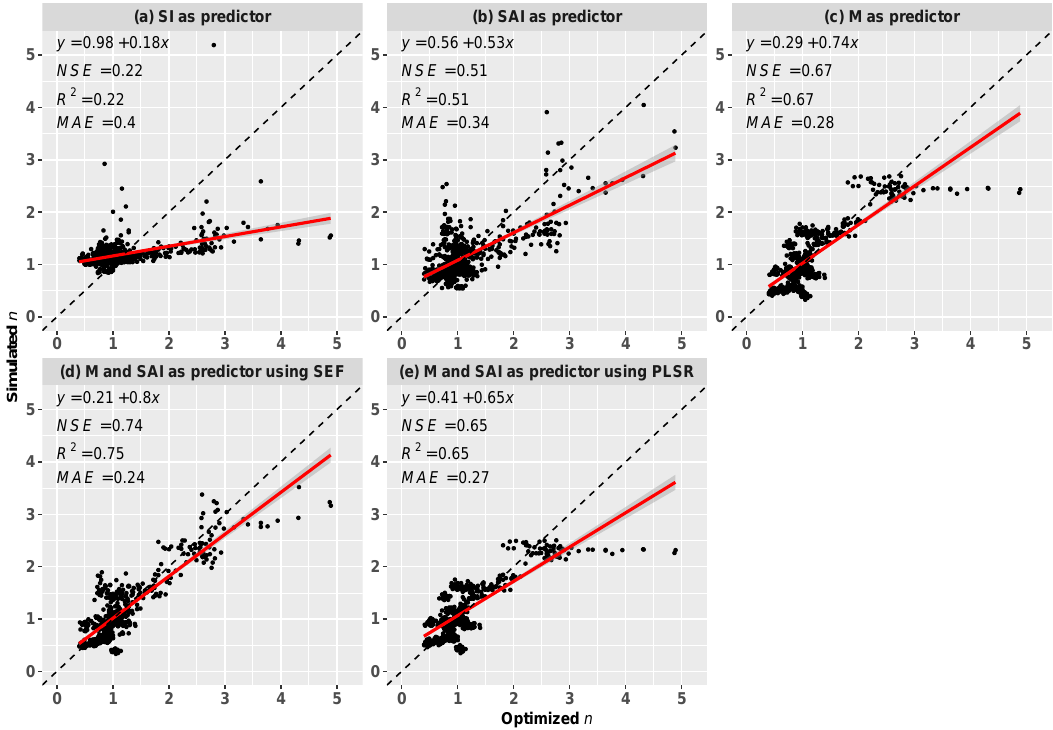
Figure 5. Optimized (calibrated) n versus simulated n modeled by (a) SI, (b) SAI, (c) M , (d) M and SAI using the semi-empirical formula (SEF, Eq. 14), and (e) M and SAI using the partial least square regression (PLSR). Note that each point represents one year based on the combined dataset from 26 global large